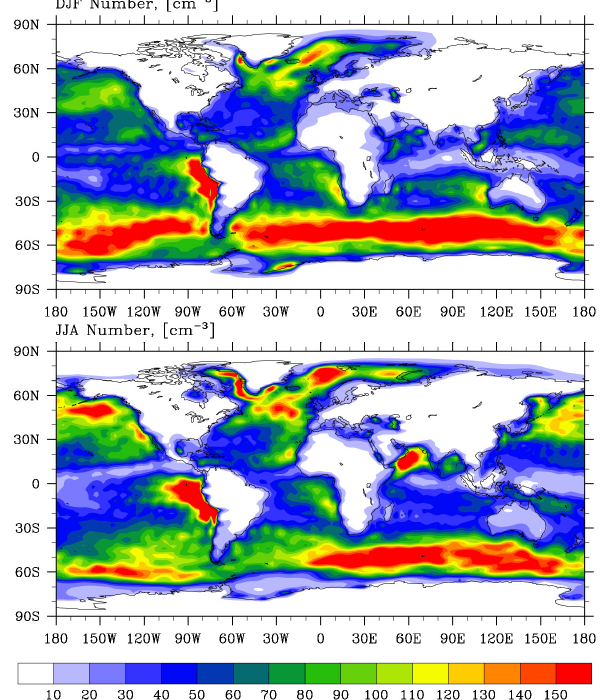
Fig. 19. Modeled global distribution of SSA optical depth in the boreal winter (DJF, December, January, and February) and summer (JJA, June, July, and August) of 2006. The model used the CMS source function and a solubility factor of 0.5.